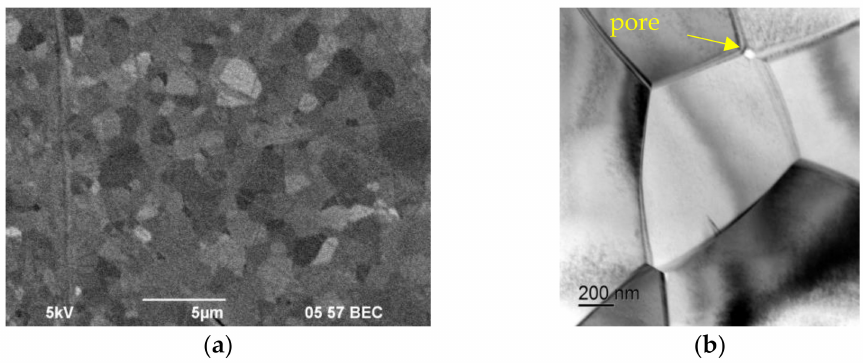
Figure 7. Microstructure of Al 2 O 3 sample ( Т = 1520 ◦ C, V = 100 ◦ C/min): ( a ) SEM, ( b ) TEM. The pores are marked with